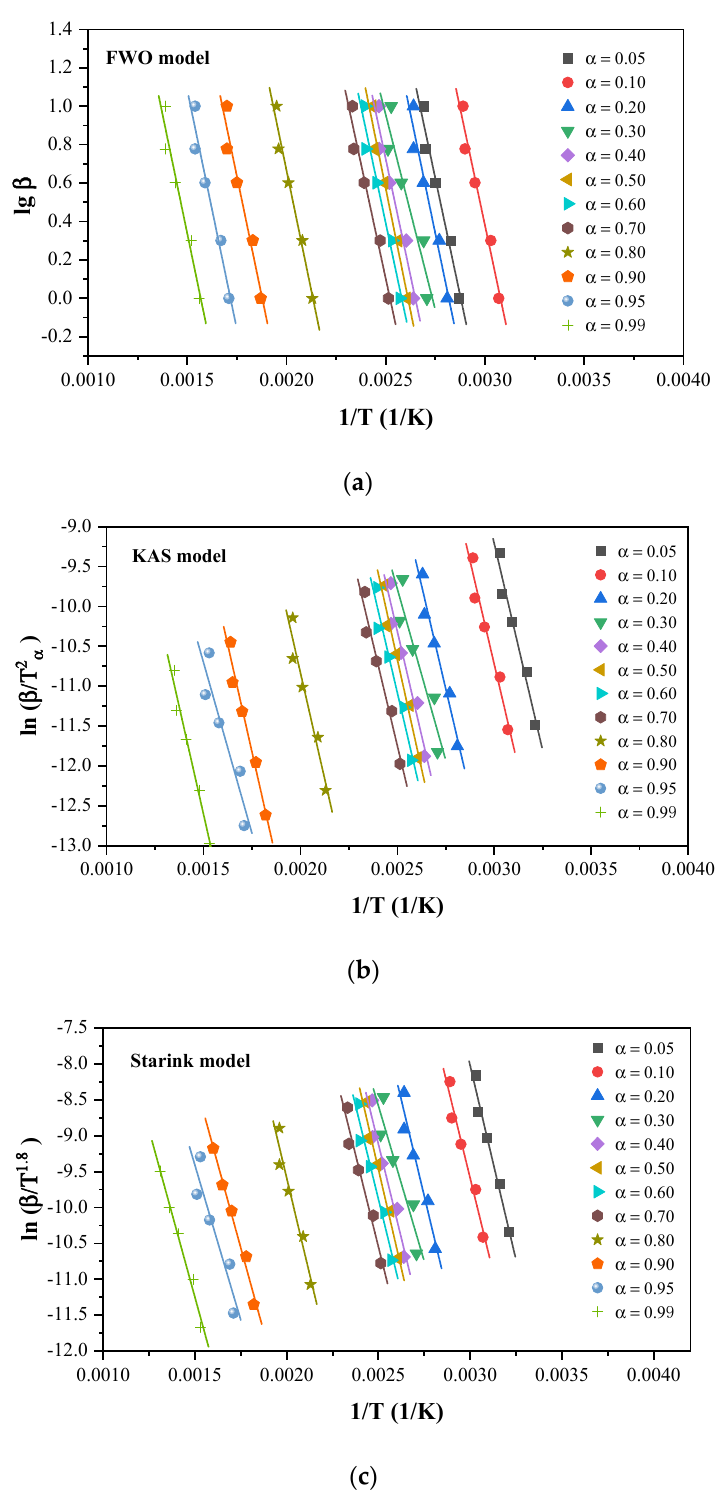
Figure 8. Differential isoconversional analysis of lithiated anode with BL-TCN using three methods at 1, 2, 4, 6, and 10 °C/min in TG experiments: ( a ) KAS model; ( b ) FWO model; ( c ) Starink model.